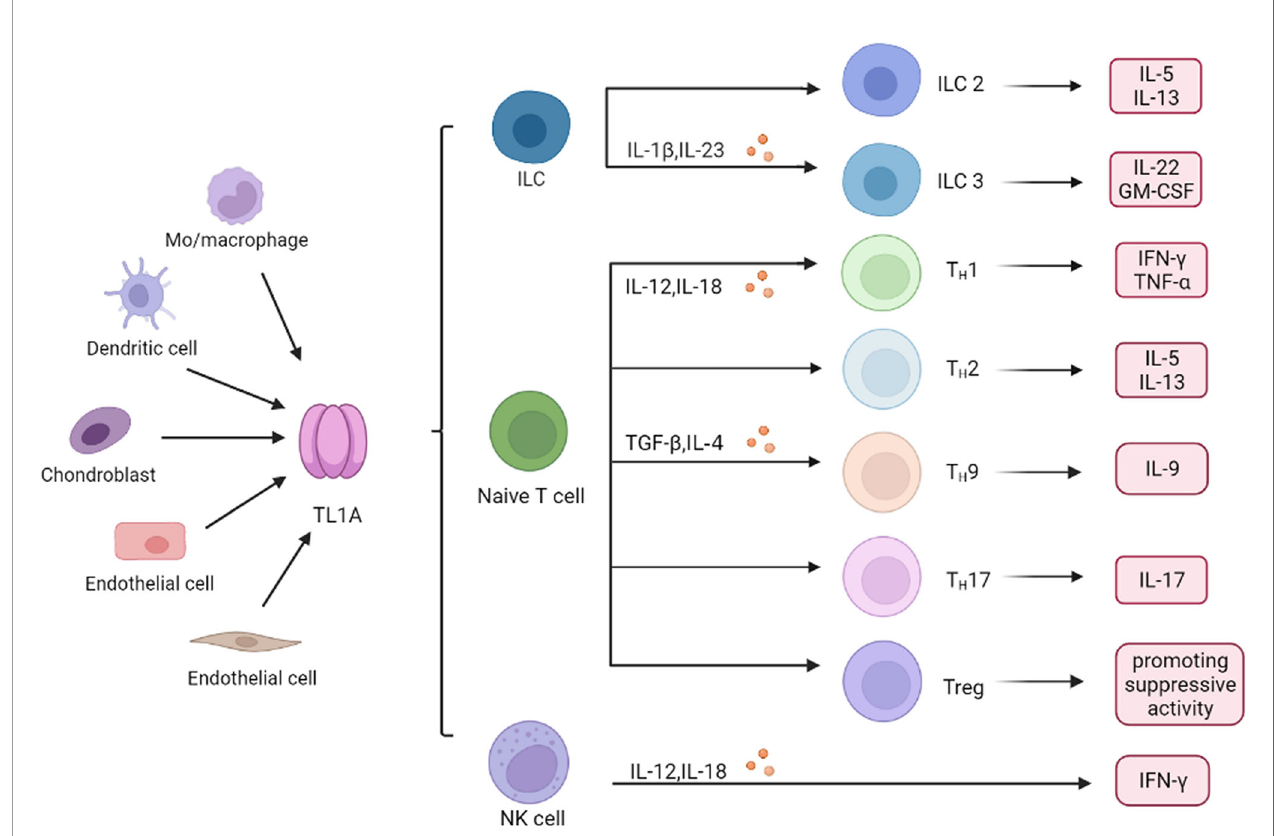
FIGURE 2 | Role of TL1A in immune cells. Monocyte (Mo) and macrophage, endothelial cells, dendritic cell, chondrocyte, and synovial fi broblast produce TL1A, which regulates production of in fl ammatory cytokines and chemokines in different immune cells, including ILC, T cells and NK cells. ILC, innate lymphoid cells; NK cell, natural killer cell; Th, helper T cell; IL-1 b , interleukin-1 b ; TNF- a , tumor necrosis factor- a ; TGF- b , transforming growth factor- b ; GM-CSF, granulocytemacrophage colony stimulating factor; IFN- g , interferon − g